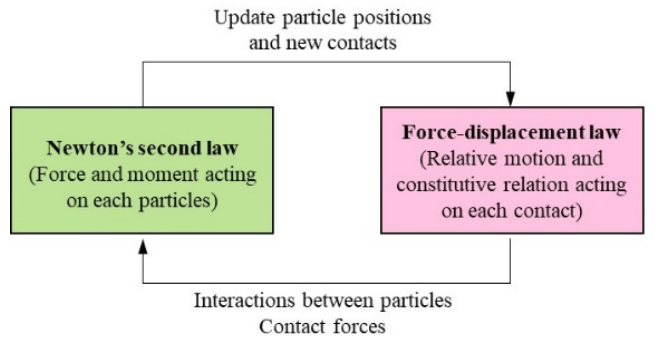
Figure 9. Flow chart of PFC calculation.